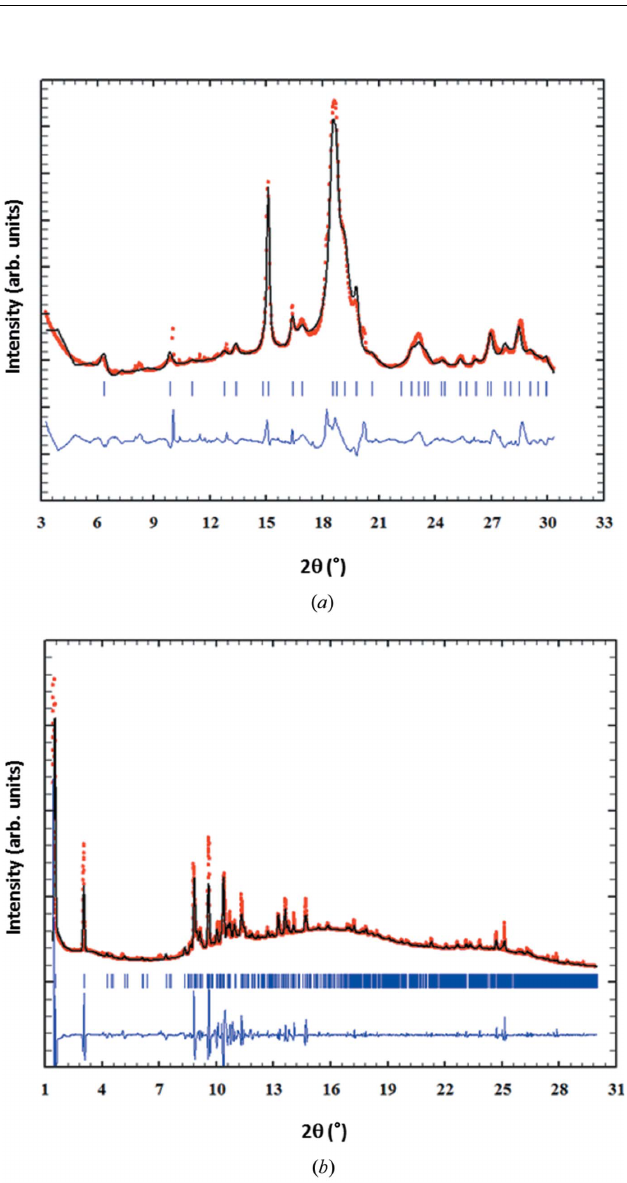
Figure 4 Analysis of nano- and microcrystalline structures. ( a ) Experimental (red dots), best fit (full black line) and the difference curve (blue curve), as obtained after the Rietveld fit of the hydroxyapatite structure (ICSD code 187840) and ( b ) experimental (red dots), best fit (full black line) and the difference curve (blue curve), as obtained after the Le Bail fit of the triclinic cholesterol hemimethanolate (COD code 220-0959).